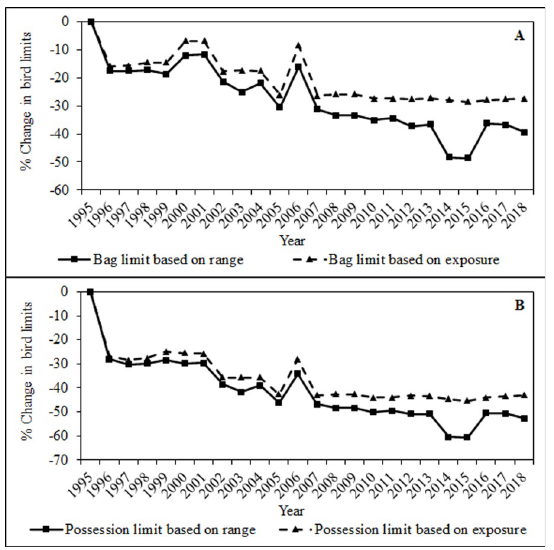
Fig 5. Change over time in average bag limits (A) and possession limits (B) of greater sage-grouse, 1995–2018 . The solid line represents averaged season length within 8 km of all active greater sage-grouse leks, and the dashed line represents averaged season length within 8 km of active leks with direct exposure to legal harvest in a given